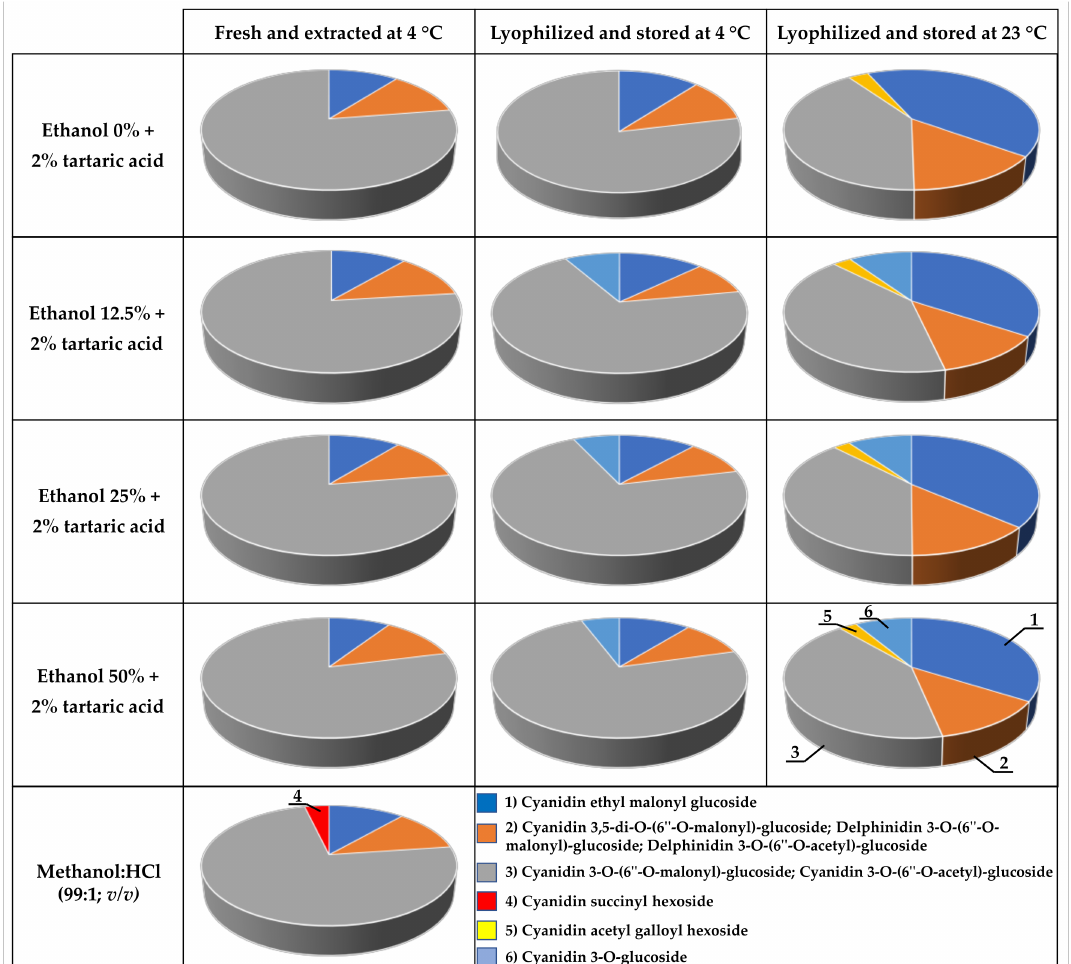
Figure 9. Anthocyanin profile of red chicory extracts. Values refer to peak areas in arbitrary units (AU) extrapolated from HPLC-DAD data at 520 nm. Cyan: relative amount of cyanidin 3- O -glucoside. Orange: sum of cyanidin 3,5-di- O -(6”- O - malonyl)-glucoside, delphinidin 3- O -(6”- O -malonyl)-glucoside and delphinidin 3- O -(6”- O -acetyl)-glucoside. Gray: sum of cyanidin 3- O -(6”- O -malonyl)-glucoside and cyanidin 3- O -(6”- O -acetyl)-glucoside. Red: relative amount of cyanidin succinyl hexoside. Yellow: relative amount of cyanidin derivative 1. Blue: relative amount of cyanidin derivative 2. Numbers indicate the corresponding peaks in Supplementary Figure